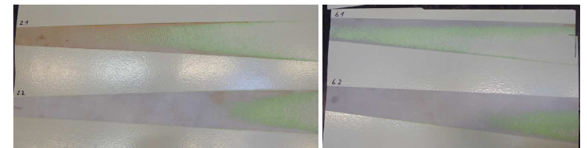
Fig. 3. Experimental results: quite abrupt transition between good and insufficient cleaning. Here, we increased the distance to the plate until colored and therefore still coated areas of the workpiece remained. Other parameters were determined in the same way, such as the angle of attack, etc.